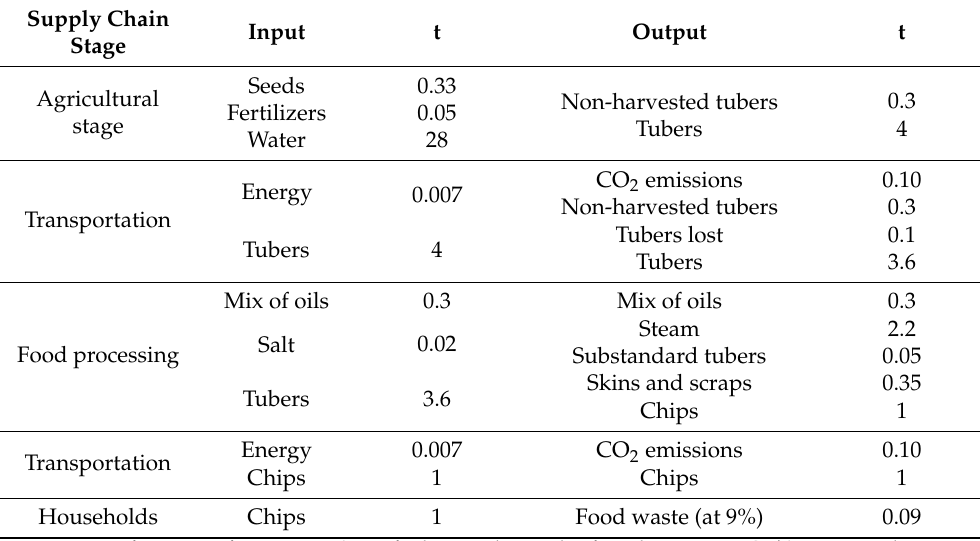
Table 1. Data inventory for 1 ton (t) of unpackaged chips (functional